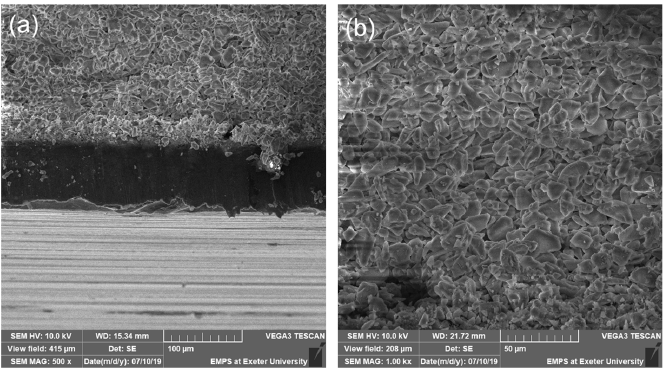
Figure 1. ( a ) SEM microstructural cross-sectional and ( b ) corresponding surface image of the de- veloped graphene coating on the (5 cm × 5 cm) low-iron glass.